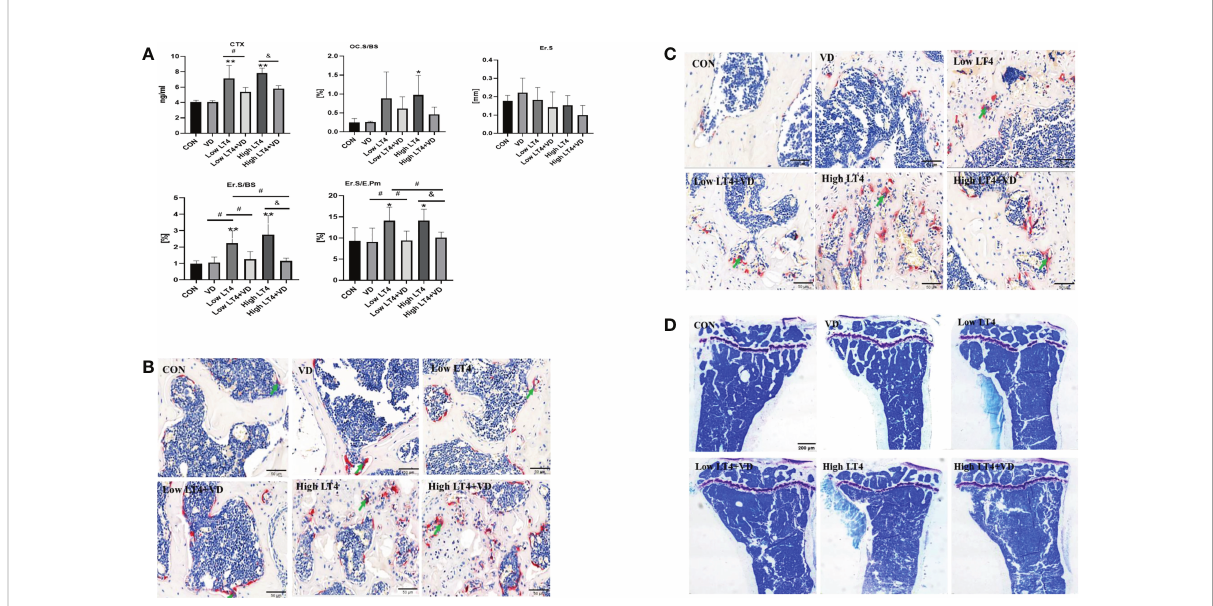
FIGURE 2 Bone resorption is increased in mice with thyrotoxicosis and suppressed through treatment with vitamin D. (A) Bone resorption parameters were determined in the CON, VD, Low LT4, Low LT4+VD, High LT4 and High LT4+VD groups. CTX, type I collagen carboxy-terminal peptide; Oc. S/BS, osteoclast surface per bone surface; Er. S, eroded surface; Er. S/BS, eroded surface per bone surface; Er. S/E. Pm, elongated surface/ endocortical perimeter. (B) Representative TRAP staining on vertebral slides in the CON, VD, Low LT4, Low LT4+VD, High LT4 and High LT4+VD groups. (C) Representative TRAP staining on femur slides in the CON, VD, Low LT4, Low LT4+VD, High LT4 and High LT4+VD groups. (D) Toluidine blue staining of cancellous bone in the metaphysis of the upper tibia of mice in the CON, VD, Low LT4, Low LT4+VD, High LT4 and High LT4+VD groups. (A) Data are shown as the means ± SEMs (n=6). Compared with the CON group, * P < 0.05, ** P < 0.01. Compared with the Low LT4 group, # P < 0.05, compared with the High LT4 group, & P <